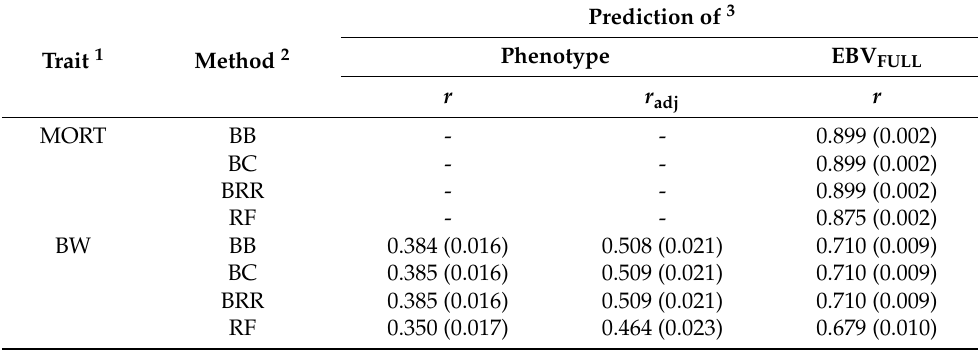
Figure 1. Manhattan plots for genome-wide associations between genotypes at 16,075 SNP and: ( a ) VNN post-challenge mortality, ( b ) square root of serum cortisol concentration (ng 0.5 / mL0.5 ) and ( c ) antibody titer (sample-to-positive ratio of the optical density (OD) values, 450 nm). The red line indicates the genome-wide significance threshold p = 0.05/N (N = total number of SNP) after Bonferroni correction and − log 10 transformation. Table 1. Average accuracy (SD) of predictions of the phenotype or EBV FULL for the investigated traits provided by the Bayesian models and the Random Forest algorithm in 16 independent five-fold